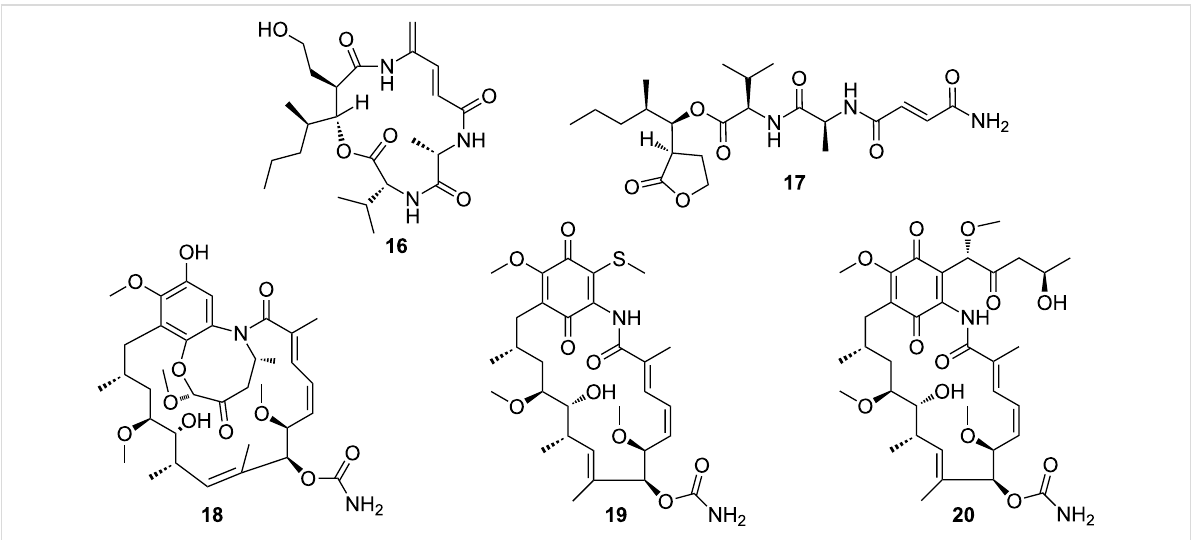
Figure 6: Secondary metabolites isolated from Actinobacteria from fungus-growing termites. Microtermolide A ( 16 ), microtermolide B ( 17 ), natalamycin A ( 18 ), 19- S -methylgeldanamycin ( 19 ), and 19-[(1 S ,4 R )-4-hydroxy-1-methoxy-2-oxopentyl]geldanamycin ( 20 ).